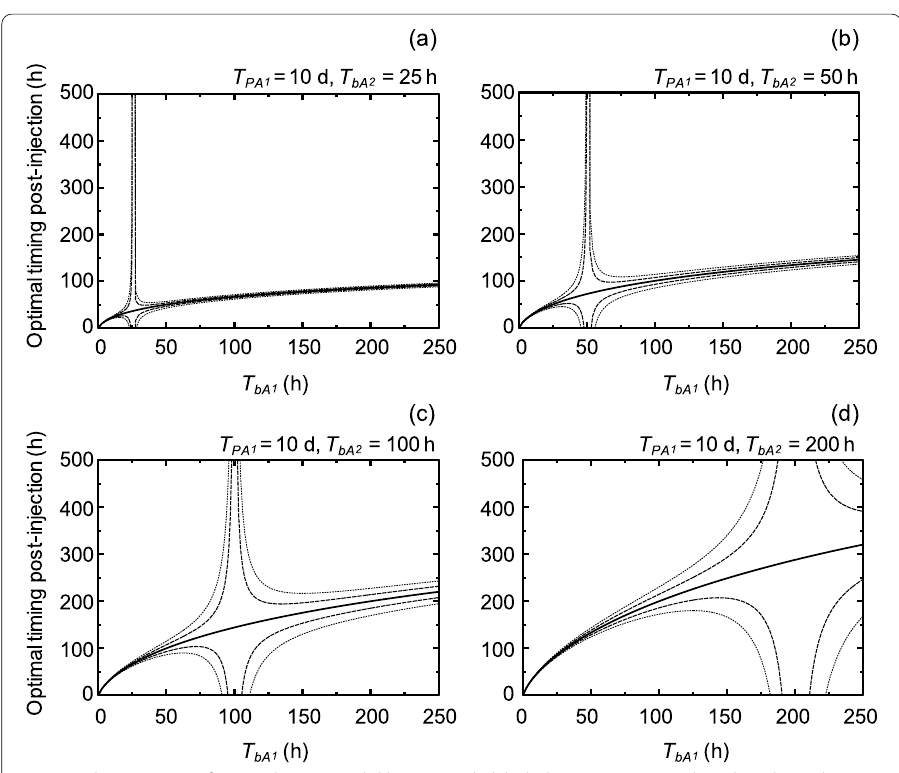
Fig. 4 Behavior maps of optimal timing (solid line) on radiolabeled target compounds with a physical HL of 10 d. T pA1 and T bA 1 are the physical HL and HL of the biological clearance of a target, respectively. T bA 2 is the half-life of the biological clearance of a reference. Behavior maps of T bA 2 in these cases of 25, 50, 100, and 200 h are presented in the panels of ( a ), ( b ), ( c ), and ( d ), respectively. The dashed and dotted lines represent optimal timing in the cases of 0.95 and 1.05, and 0.9 and 1.1 times converted absorbed doses,